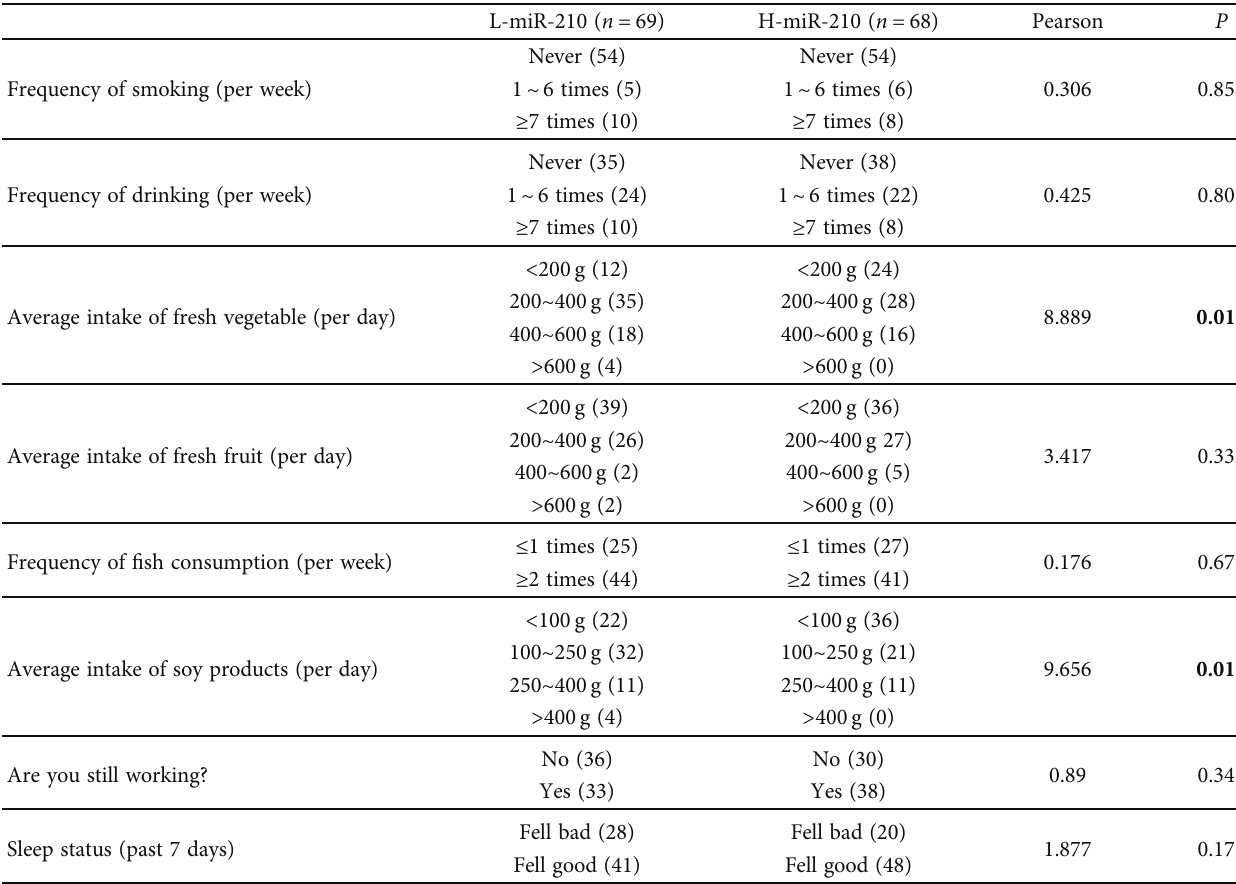
Table 5: The correlation of dietary patterns with high and low miR-210 level groups in patients with type 2 diabetes